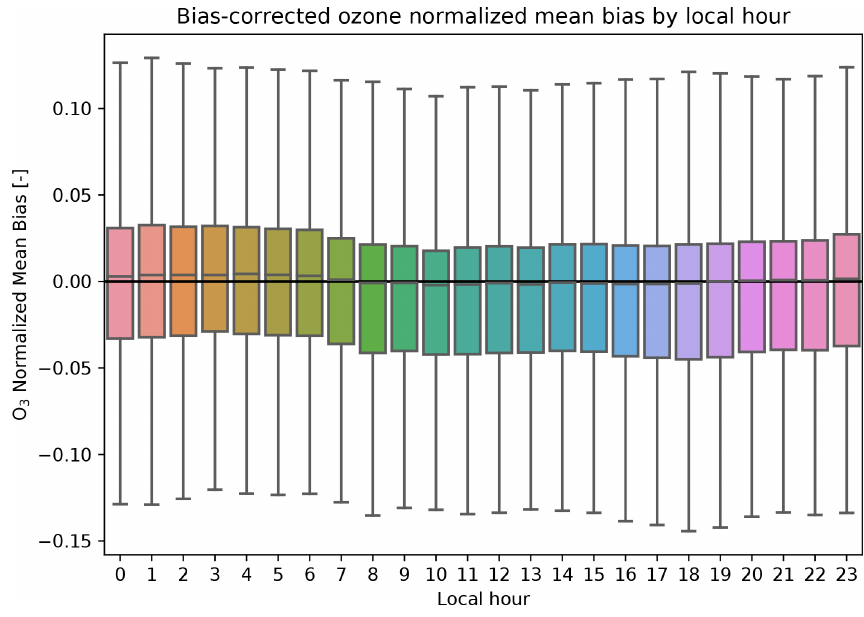
Figure A13. The same as Fig. A12 but for